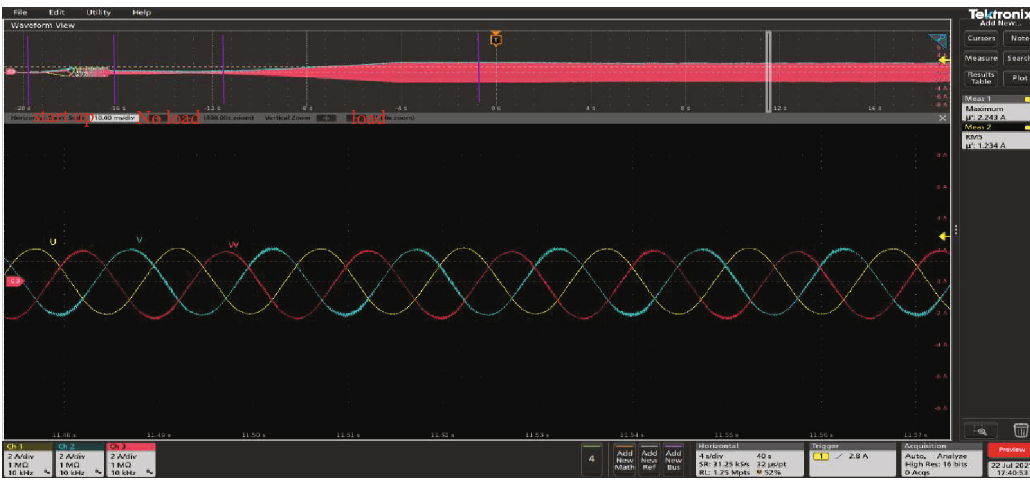
Figure 31: Phase current waveform for proposed method.